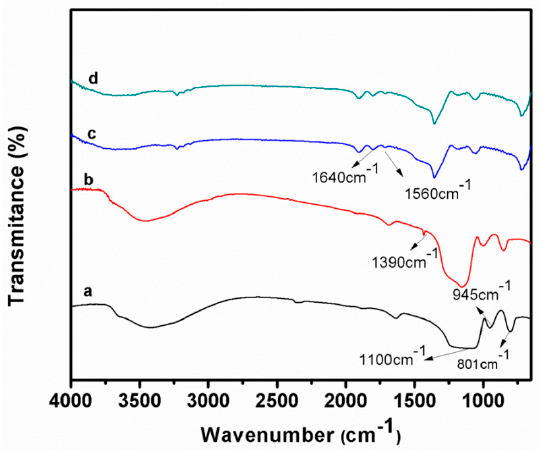
Figure 2. FT-IR spectra of ( a ) bare silica microspheres; ( b ) BiBB-functionalized silica microspheres; and SPMs ( c ) below and ( d ) above the LCST.